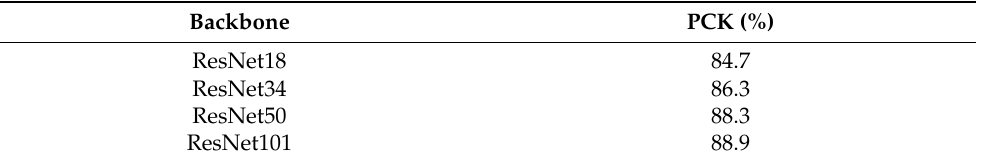
Table 3. Pre-training results for the residual network with different depths.